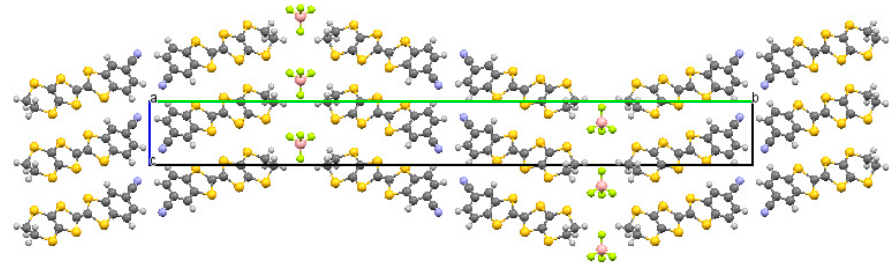
Figure 2. Crystal structure of β ”-(CNB-EDT-TTF) 4 BF 4 viewed along a .